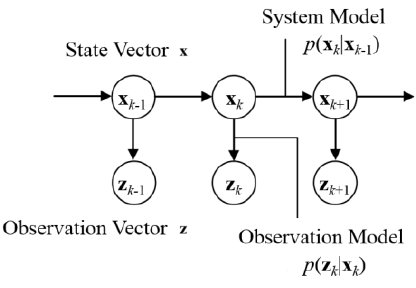
Figure 1. General state space model